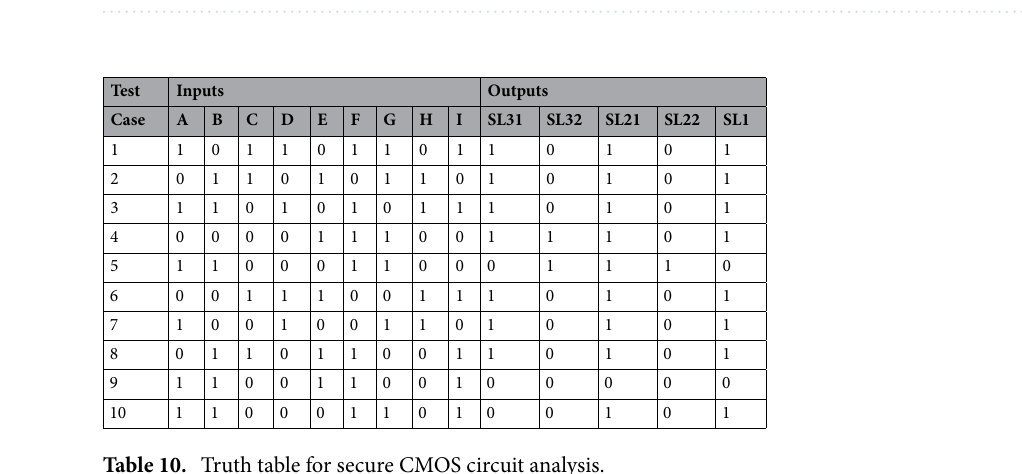
Figure 22. circuit with proposed CMOS gates.